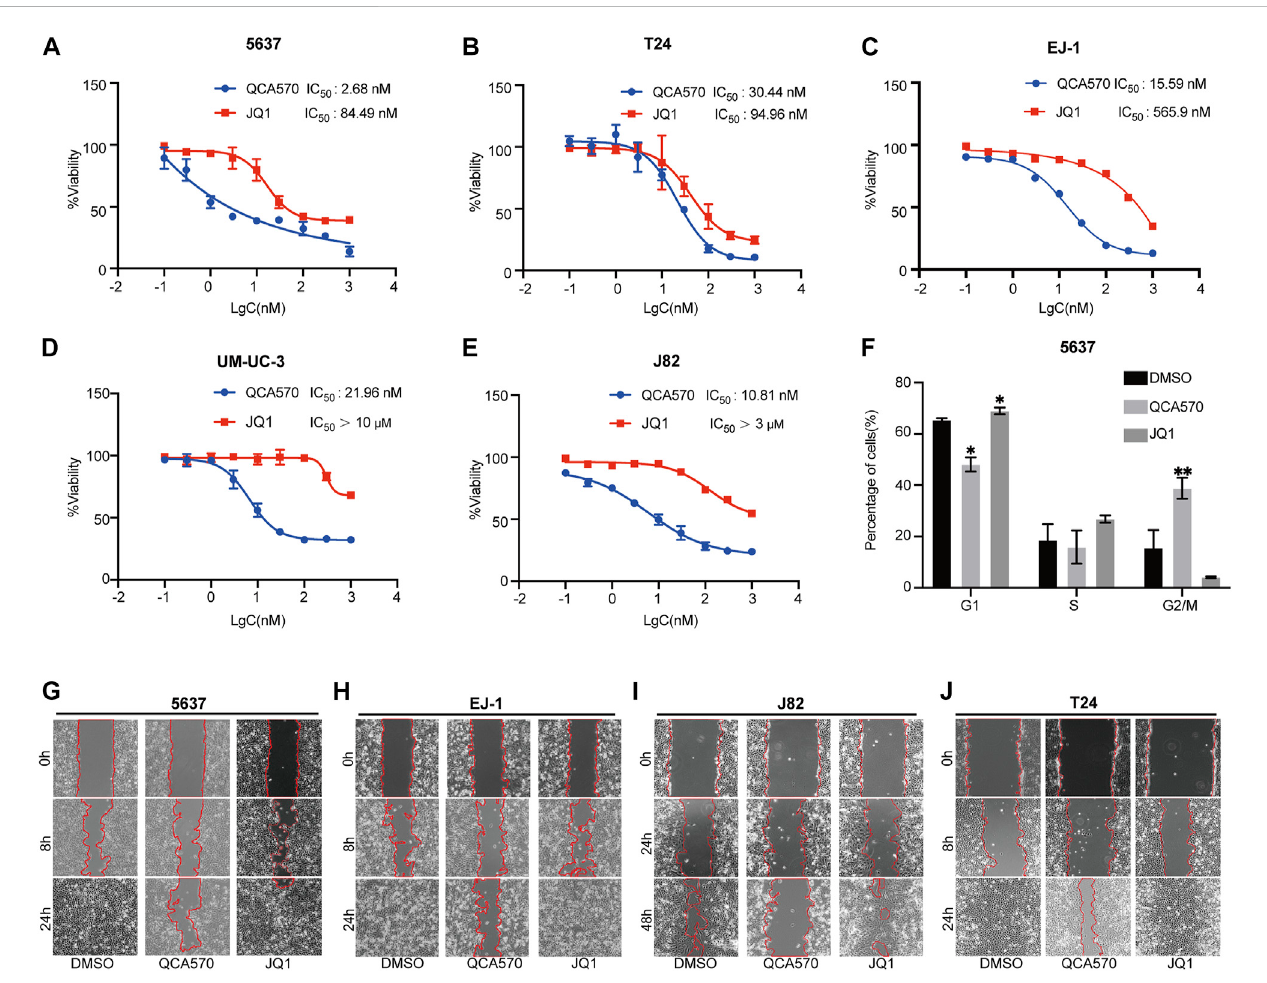
FIGURE 4 QCA570 treatment inhibits BC cell proliferation and migration (A – E) Antiproliferative effect of QCA570 or JQ1 in BC cell lines after 72 h treatment. Cell numbersweremeasuredattheindicatedtimepointswiththeCCK-8assayandrepresentedasabsorbanceat450 nm.Valuesarethemeans±SEM,* p < 0.05; ** p < 0.01,two-tailedStudent ’ st-test. (F) 5637cellswereexposedtoQCA570(10 nM)orJQ1(10 nM)for72 hthencollectedforanalysisusing fl owcytometry. Data was analyzed using Flowjo software and the quanti fi ed result was plotted with GraphPad Prism9.0. Values are the means ± SEM, * p < 0.05; ** p